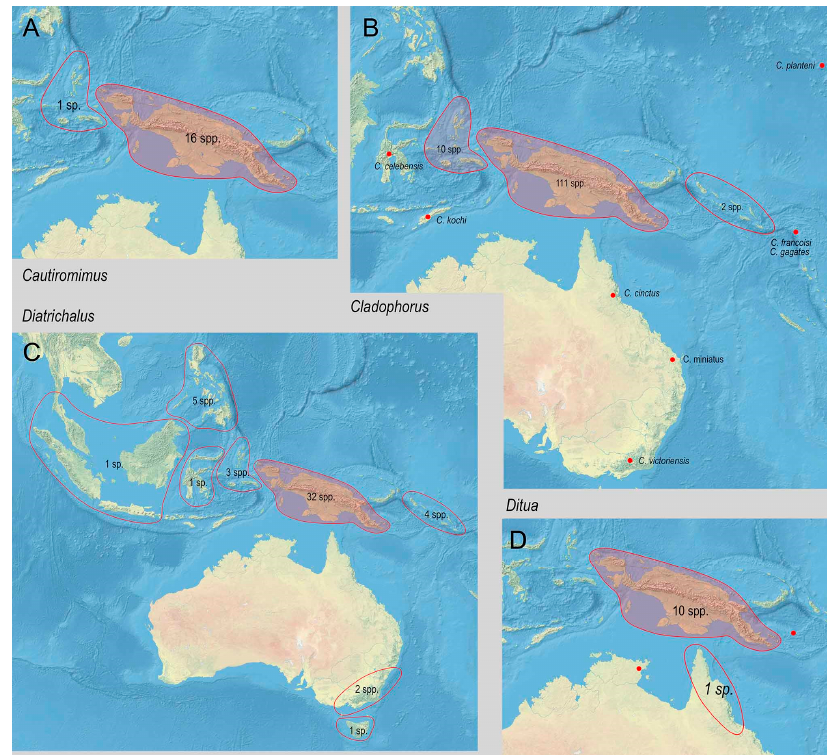
Figure 3. Distribution and diversity of Metriorrhynchina genera. ( A ) Cautiromimus Pic, 1926; ( B ) Cladophorus Guérin-Méneville, 1830; ( C ) Diatrichalus Kleine, 1926; ( D ) Ditua Waterhouse, 1979.